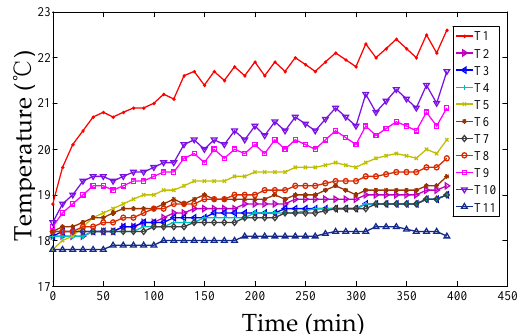
Figure 7. Temperatures of 11 temperature sensors.